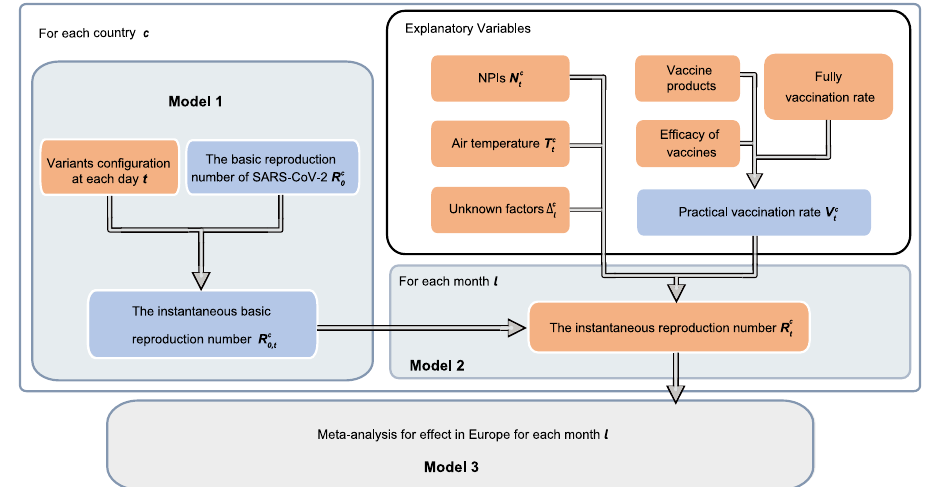
Fig. 5 Overview of models using bottom-up approaches. Orange nodes represent the observed data. Blue nodes represent the pseudo variables generated by the observed data. For each country, we put a prior on R 0 with hyperprior varying by country, where the prior mean was setted as the highest R t before